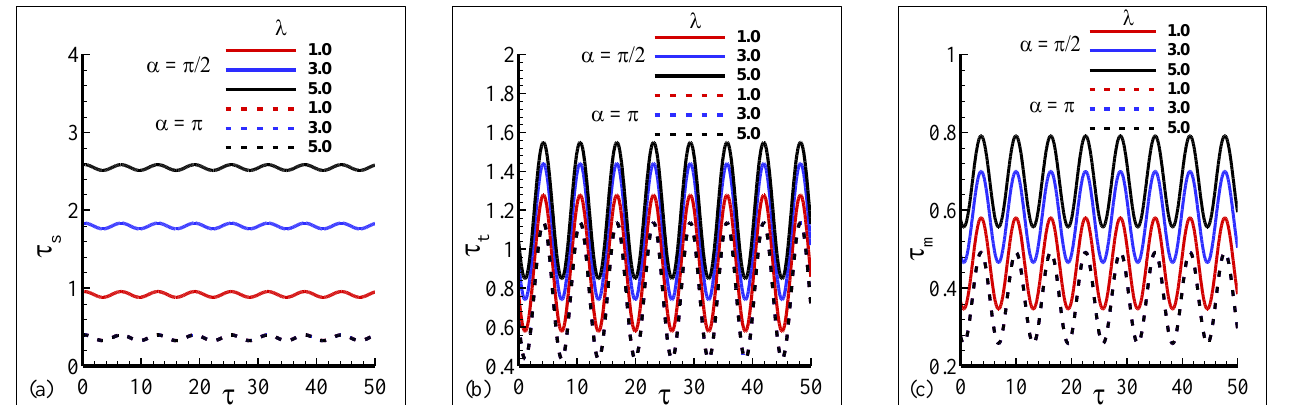
Figure 7. The geometrical plots of ( a ) 𝜏 𝑠 ( b ) 𝜏 𝑡 , and ( c ) 𝜏 𝑚 at 𝜋 2⁄ and 𝜋 positions with two values of 𝜆 = 1.0,3.0 and 5.0 with some fixed parameters 𝜉 = 0.4 , Rg = 0.1 , 𝛾 = 0.2 , and Pr = 7.0 .